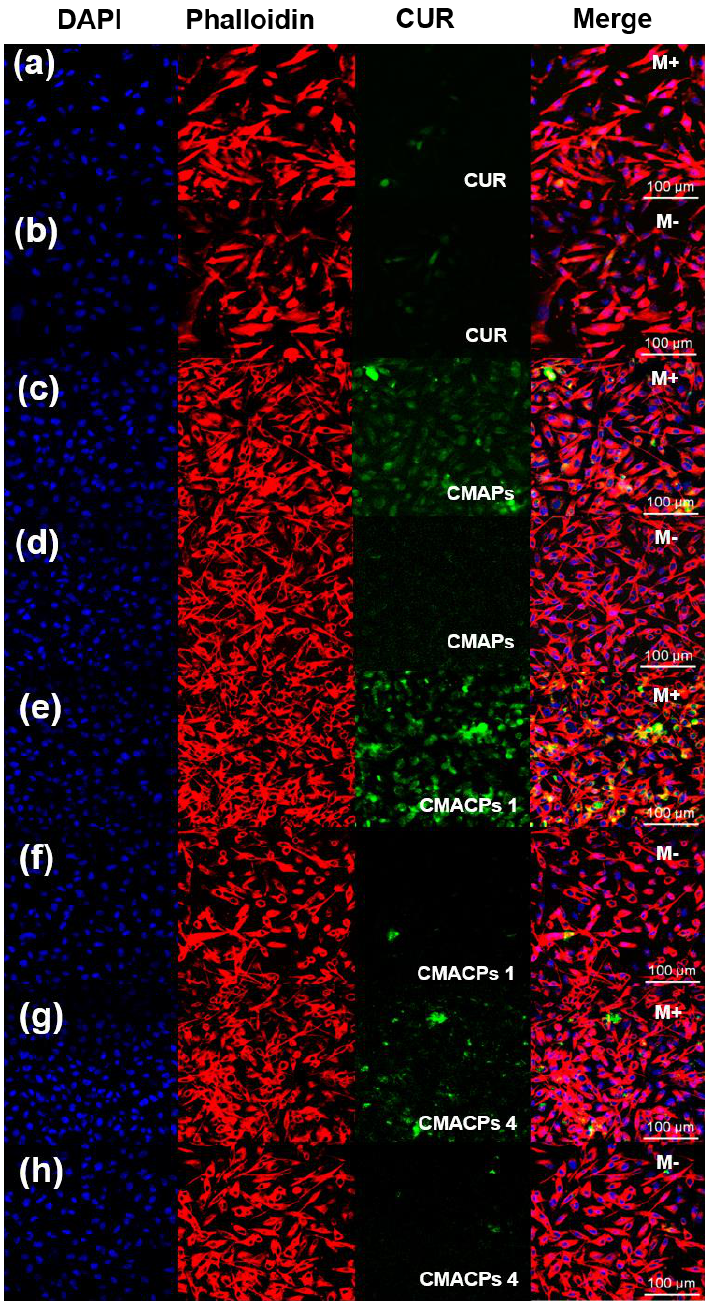
Figure 7. Confocal fluorescence microscopy images of MDA-MB-231 cells incubated with free CUR ( a , b ), CMAPs ( c , d ), CMACPs 1 ( e , f ) and CMACPs 4 ( g , h ). CMACPs 1 and 4 represent CMACPs that possess 1 and 4 layers of polymers coated on MNPs respectively. CUR loaded particles contained equivalent amount of drug as free CUR (5 μg/mL). Cell nucleus and cytoskeleton were stained with DAPI (blue) and Alexa Fluor 568 Phalloidin (red). M+ denotes the images taken within the magnet affected area and M- denotes the images taken outside of the magnet-affected target area.